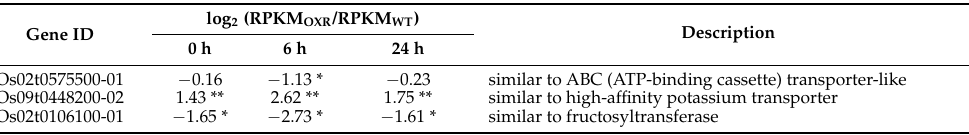
Figure 4. KEGG pathway analysis of ethylene signal and JA signal pathways. Each rectangular box represents genes that are mapped to Oryza sativa in the species-specific pathway map. Boxes with pink background indicate the corresponding genes were up-regulated in the OXR samples compared with WT samples at some tested point in time, as determined by RNA-seq. Blue background indicates down-regulated and green background indicates corresponding genes did not exhibit obvious expression differences at any tested time point between OXR samples and WT samples. ( A ) PEG treatment group; ( B ) salt treatment group. The arrows with white colors indicate linking to another map; arrows with black color indicate molecular interaction or relation. Table 1. List of DEGs related to osmotic adjustment under PEG treatment.